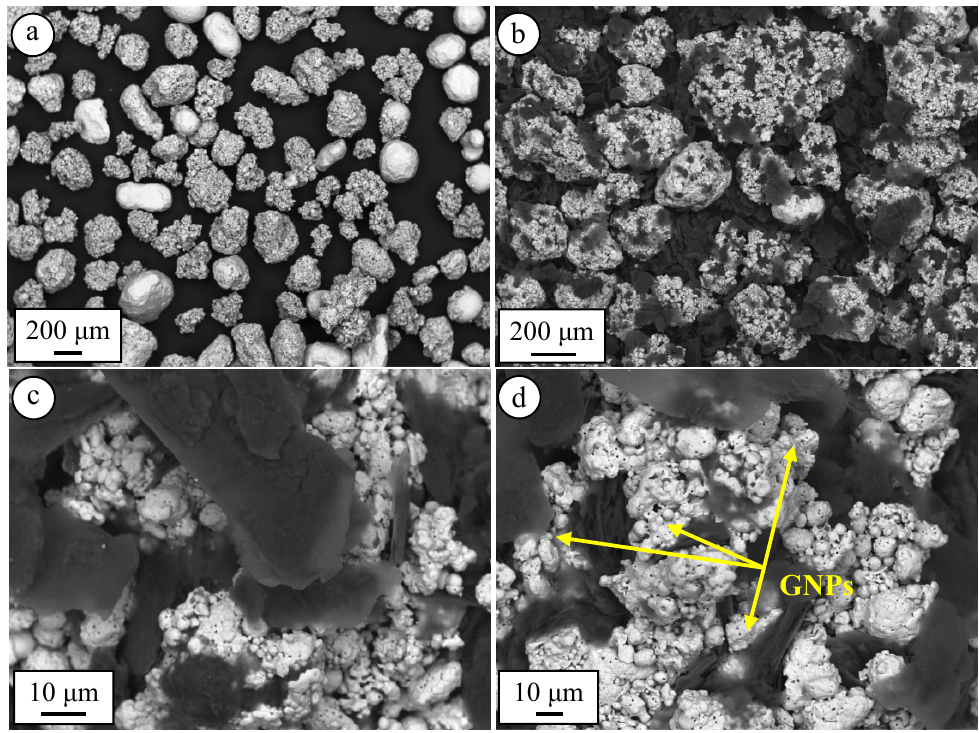
Figure 3. SEM images of ( a ) pure Cu and ( b – d ) Cu–8 Vol % GNPs composite powder mixture.